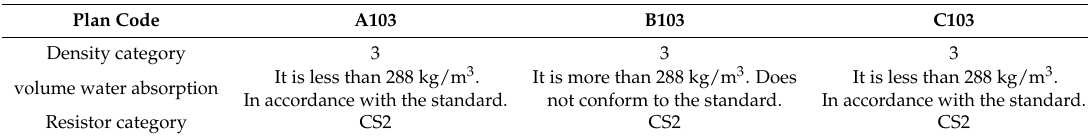
Figure 14. Comparison chart of compressive strength, density, and water absorption volume of lightweight aggregate blocks with optimal mix. Table 14. Ranking density, compressive strength, and water absorption volume of lightweight aggregate block in accordance with ISO 7782.